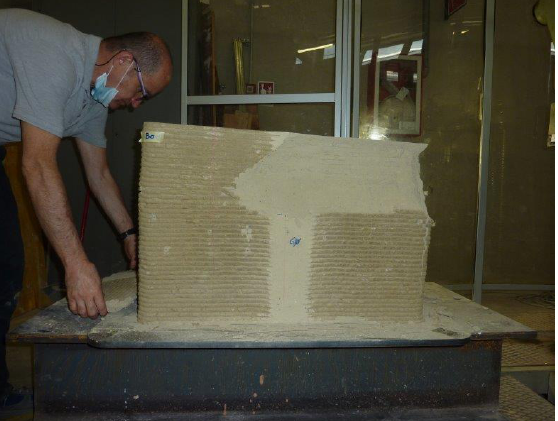
In particular, the opening of the right detachment (Figure 11b) was larger than the opening of the left detachment (Figure 11a) due to the greater elongation of edge 2 com- pared to edge 1. After the end of the load test and the removal of the specimen from the testing machine, the upper face retained a permanent value of rotation, with a left-to-right Figure 11. Details of the detachments between the horizontal layers of the side to the left of the Figure 11. Details of the detachments between the horizontal layers of the side to the left of the skew (Figure 12). operator: ( a ) left detachment, which reaches edge 1; ( b ) right detachment, which reaches edge 2. operator: ( a ) left detachment, which reaches edge 1; ( b ) right detachment, which reaches edge 2.